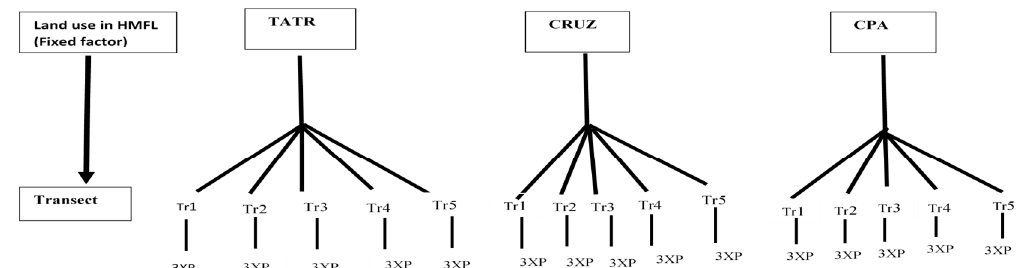
Figure 2. Schematic diagram of the sampling design of β -diversity in Human Modified Forest Landscape (HMFL) of the Forest Reserves (FR) and the conformity to Intermediate Disturbance Hypothesis (IDH).TATR = Trees Along Rivers and Streams, CRUZ = Common Resource Use Zone, CPA = Culturally Protected Forests, Tr = Transect.